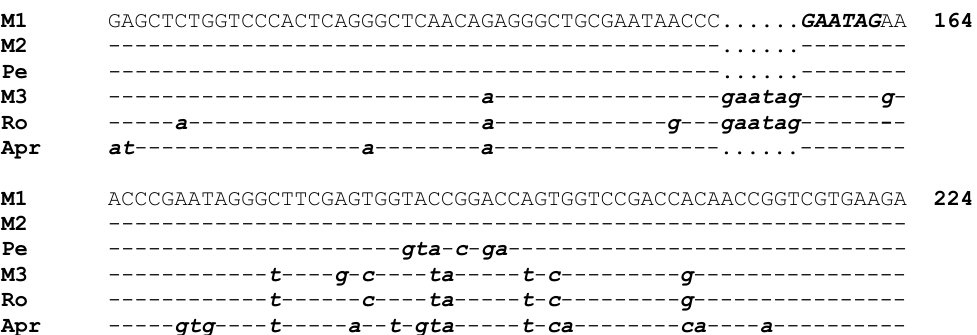
Fig. 3. Nucleotide sequence comparison. Nucleotide (nt) sequences of PCR products derived from the six Prunus necrotic ringspot virus isolates were aligned. Identical nucleotides are marked by a dash, modified ones by small letters, deletions by dots, and bold letters mark duplicated nucleotides.